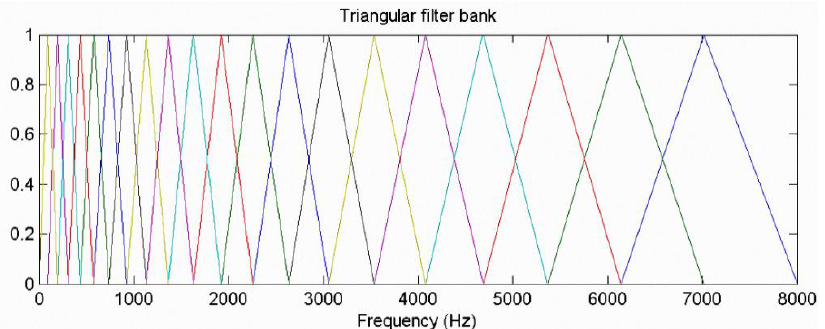
Figure 14. Triangular filter bank